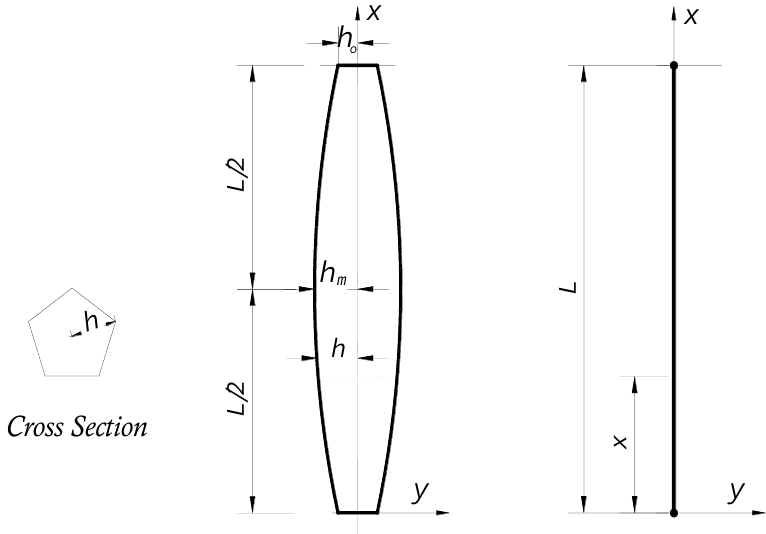
Fig. 1. Tapered column with regular polygon